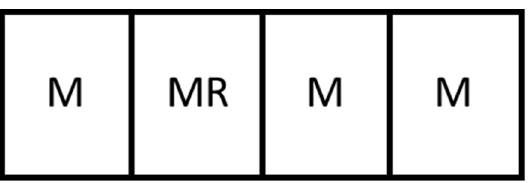
Figure 13. The optimum 4-mod design that maximizes the size of the AOS. In this case, this design can achieve a 76% larger space than the base case membrane reactor.